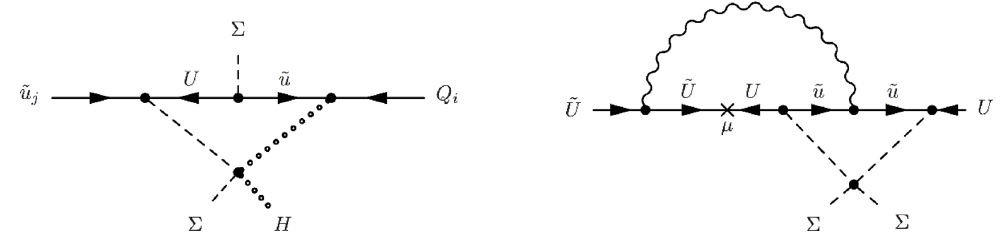
¯ Figure 2 . The leading loop corrections to θ QCD in the BBP model. Left: one-loop contributions controlled by the interactions of the CP-violating scalar with the SM Higgs. Right: two-loops “dead duck” contributions where only the CP-violating scalar